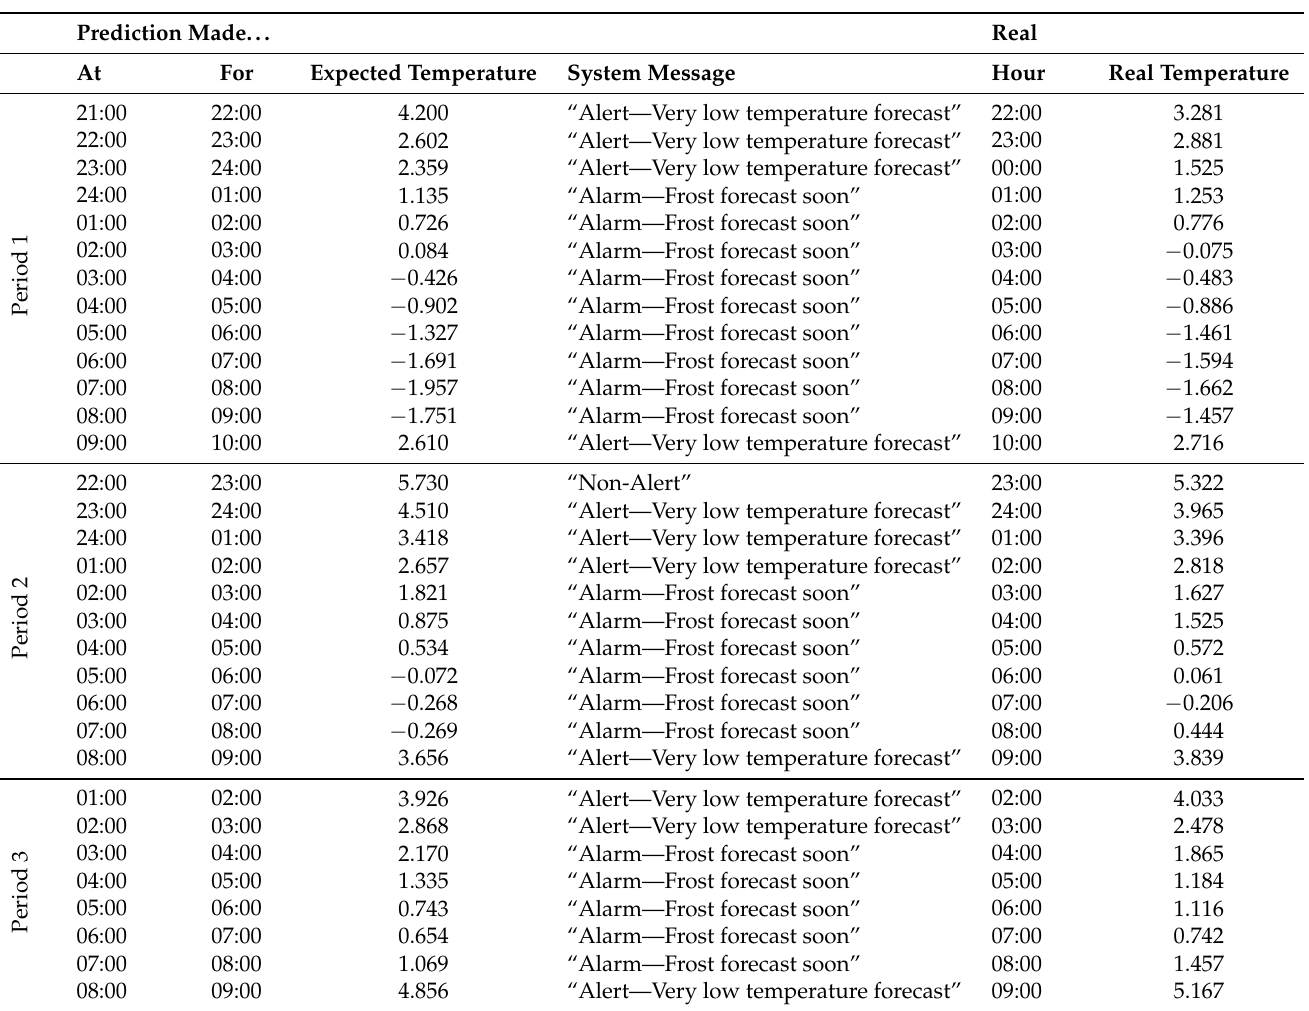
Table 4. Temperature prediction for the next hour ( h + 1) from the current information ( h ) and the previous one ( h 1). The information for the time h and h 1 corresponds to the vector (RH f , R f , − − AR, WS f , WD, RF, VPD, DE, T f ). The time at which the prediction is made, the predicted temperature one hour in advance, and the real values that occurred, are